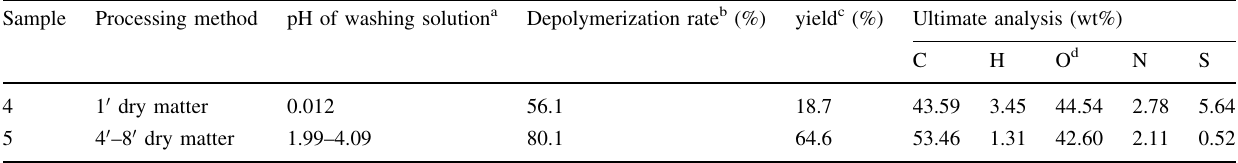
Table 2 The results of mixed acid/ultrasonic processing